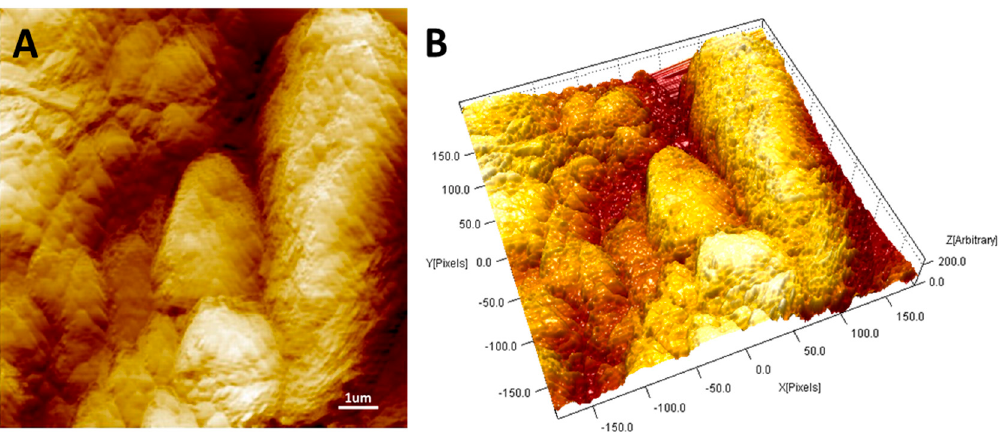
Figure 3. ( A ) Two-dimensional and ( B ) three-dimensional PAS4mg Atomic Force Microscopy (AFM) micrographs (10 × 10 µ m surface area).